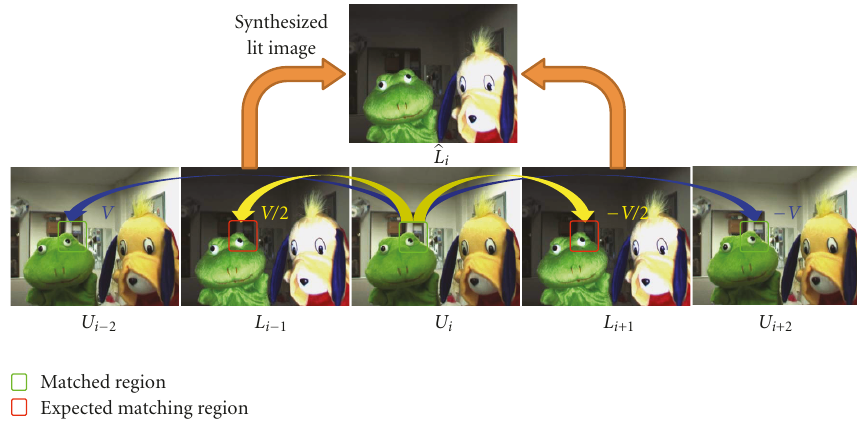
Figure 2: The proposed algorithm acquires an alternate series of lit and unlit frames. For an unlit frame U i , the proposed algorithm estimates the motion vector field, and then synthesizes the corresponding lit frame (cid:2) L i using a motion-compensated interpolation